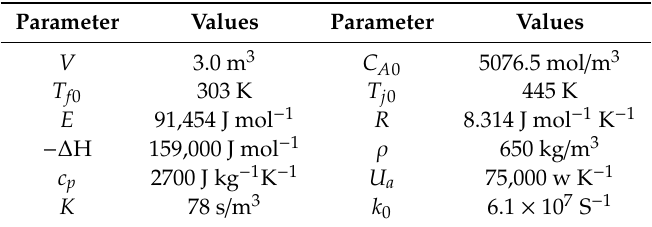
Table 2. Parameters for Oxo